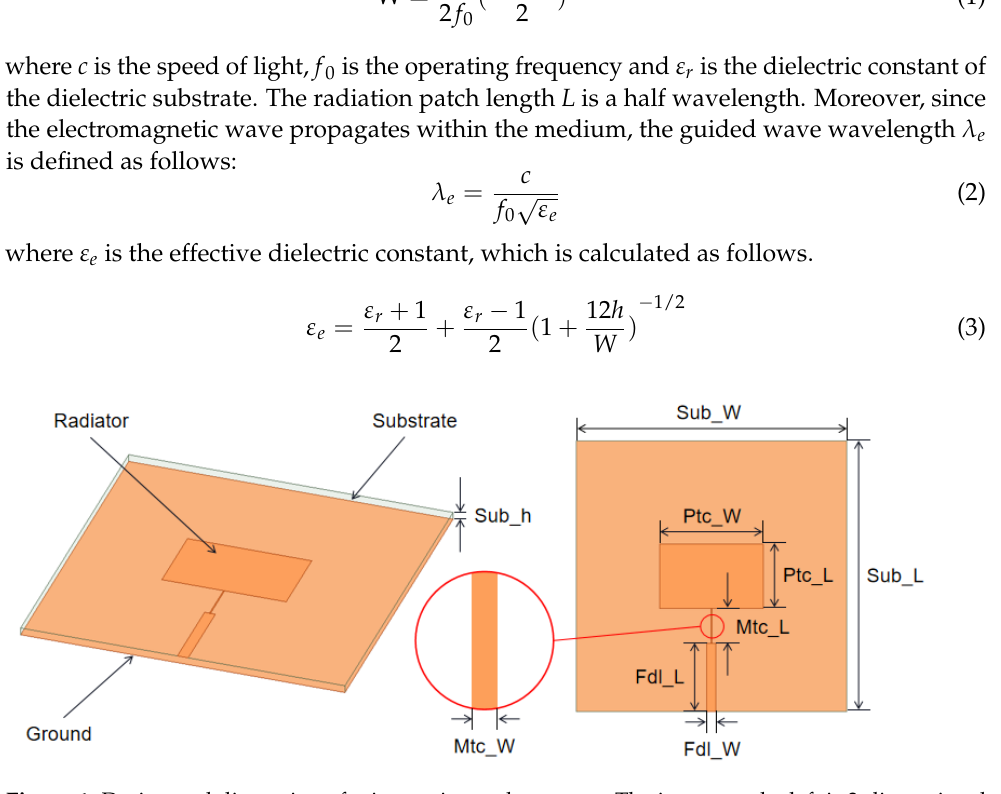
Figure 1. Design and dimension of micro-strip patch antenna. The image on the left is 3-dimensional structure. The image on the right is top view.